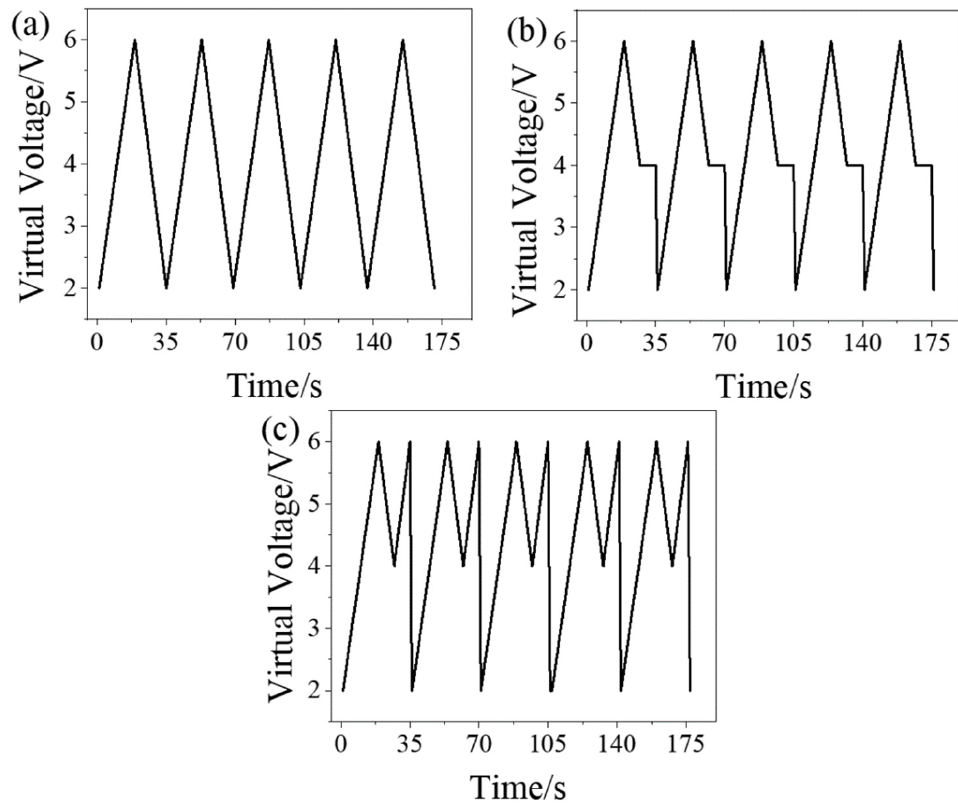
Figure 3. The heating waveforms ( a ) TW-1 ( b ) TW-2 ( c ) TW-3 .